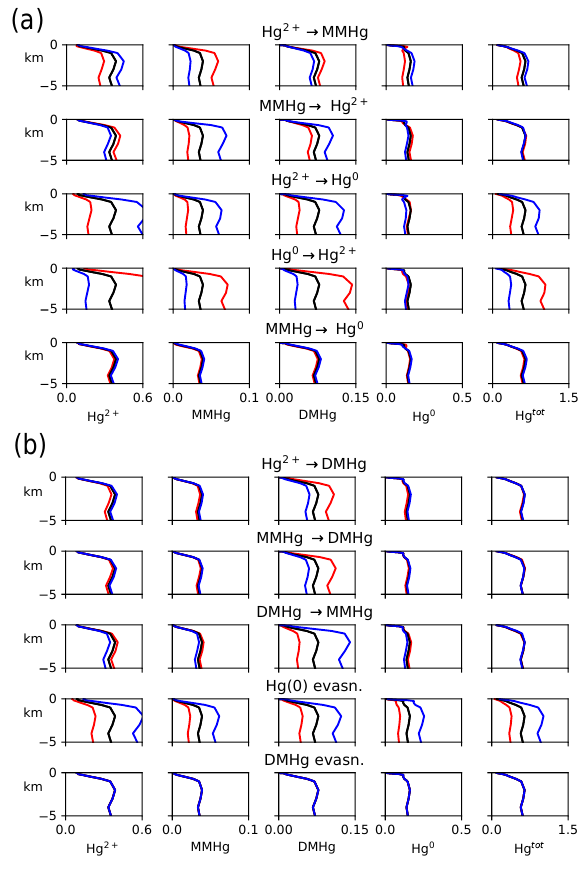
Figure 10. Model sensitivity to kinetic rate constants in the Hg sys- tem. For each kinetic rate constant as indicated in the centered ti- tles, global mean concentrations of each species are given in the four plots in that row, as indicated by the labels at the top of each column. Black lines represent the base case, and red and blue rep- resent factors of 2 higher and lower for that kinetic rate constant, respectively.